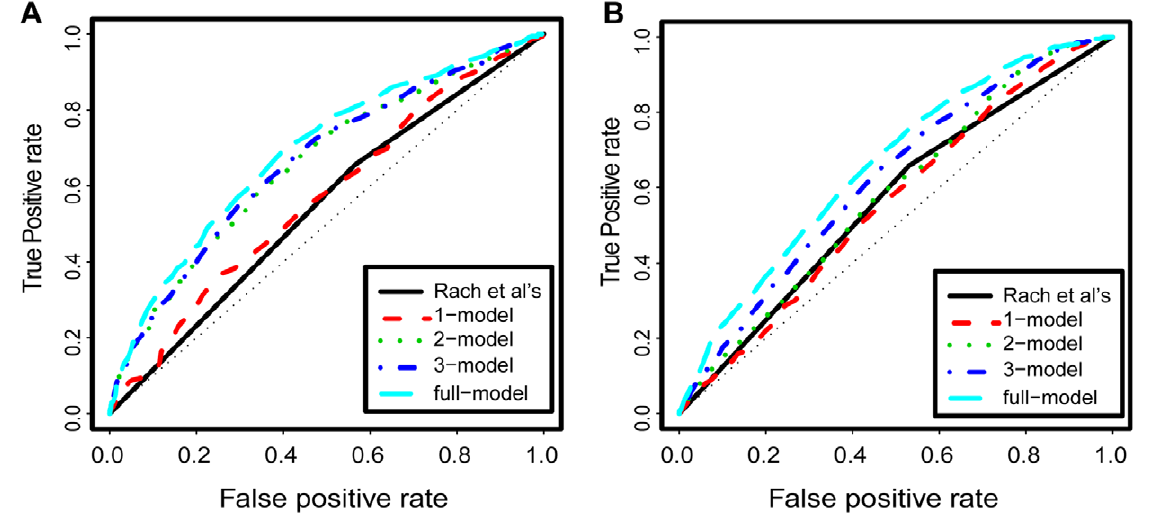
Figure 2. The receiver operating characteristic (ROC) curve for the performance of models trained in NHEK cell, and the performance of Rachetal ’s logistic regression model. A) for CpG-related promoters, and B) for nonCpG-related promoters.